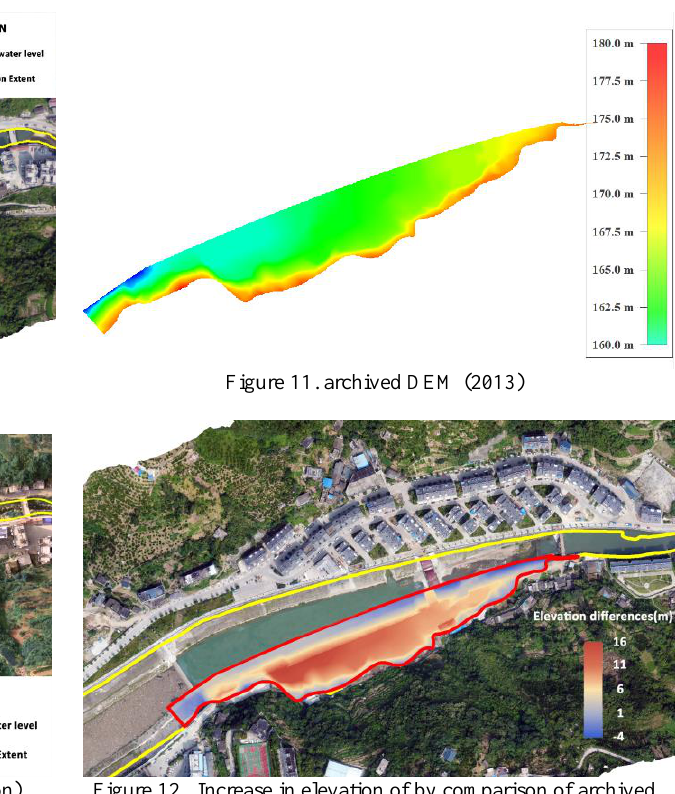
Figure 9. archived DOM of study area (before construction) To calculate TGR’s flood storage volume occupied by this construction, we overlay contour line with the height of 175m (maximum elevation of designed flood storage volume), as shown with yellow line in Figure 8 and Figure 9. The TGR’s flood storage volume occupied by this embankment construction is just the cut and fill volume below 175m, which is the shaded part in Figure 8. Buildings and vegetation were filtered from DSM to produce the DEM of the shaded extent, and the final DEM is given in FIG 10.